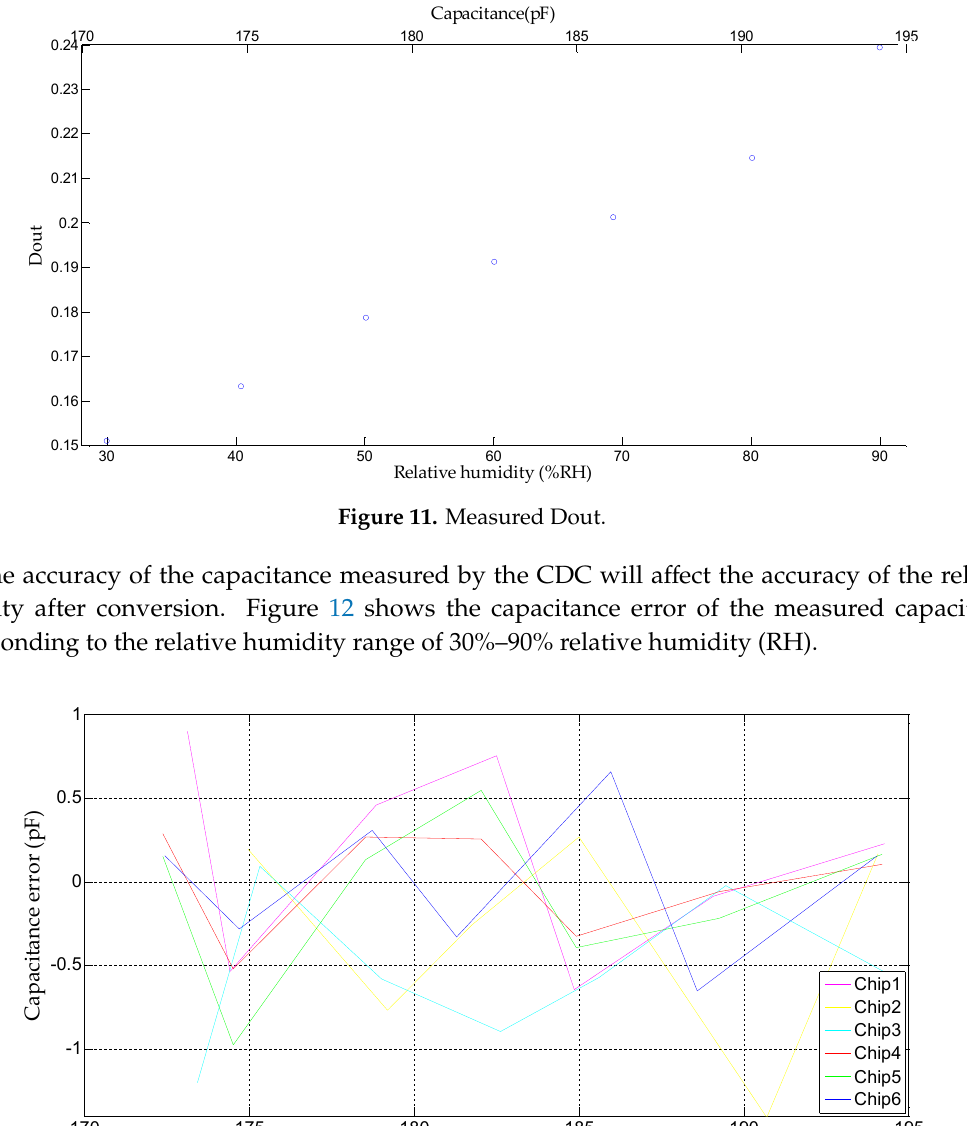
Figure 12. Error of measured capacitance at 25 °C.